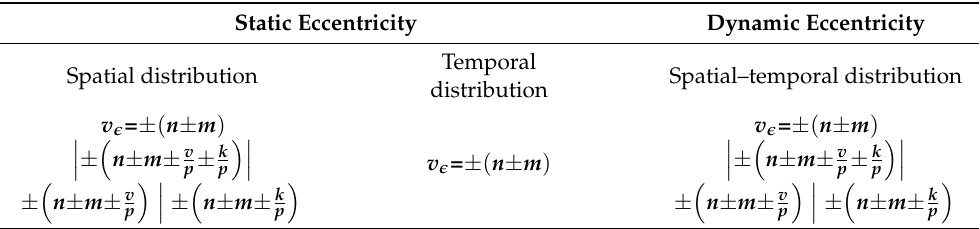
Table 9. Harmonics of the magnetic pressure in a machine with